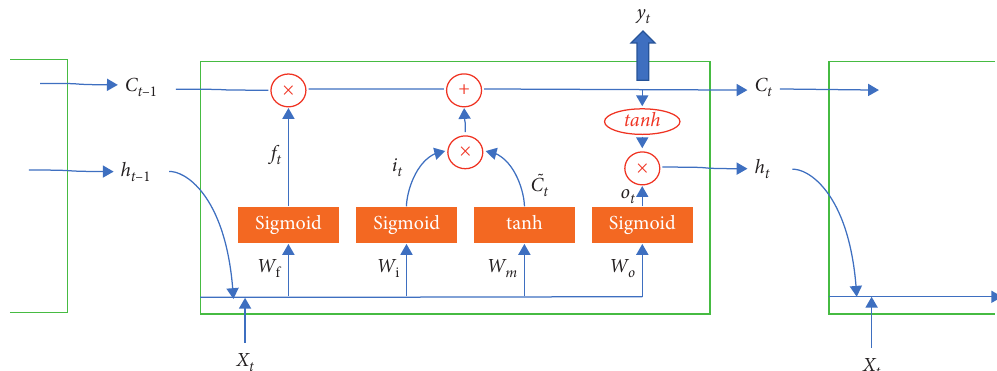
y t is the output in the current node start;